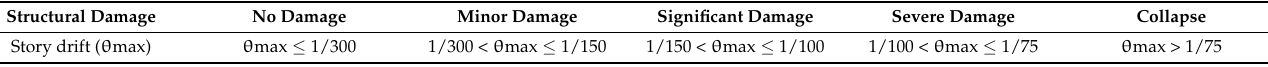
Table 6. Structural damage levels based on the story drift